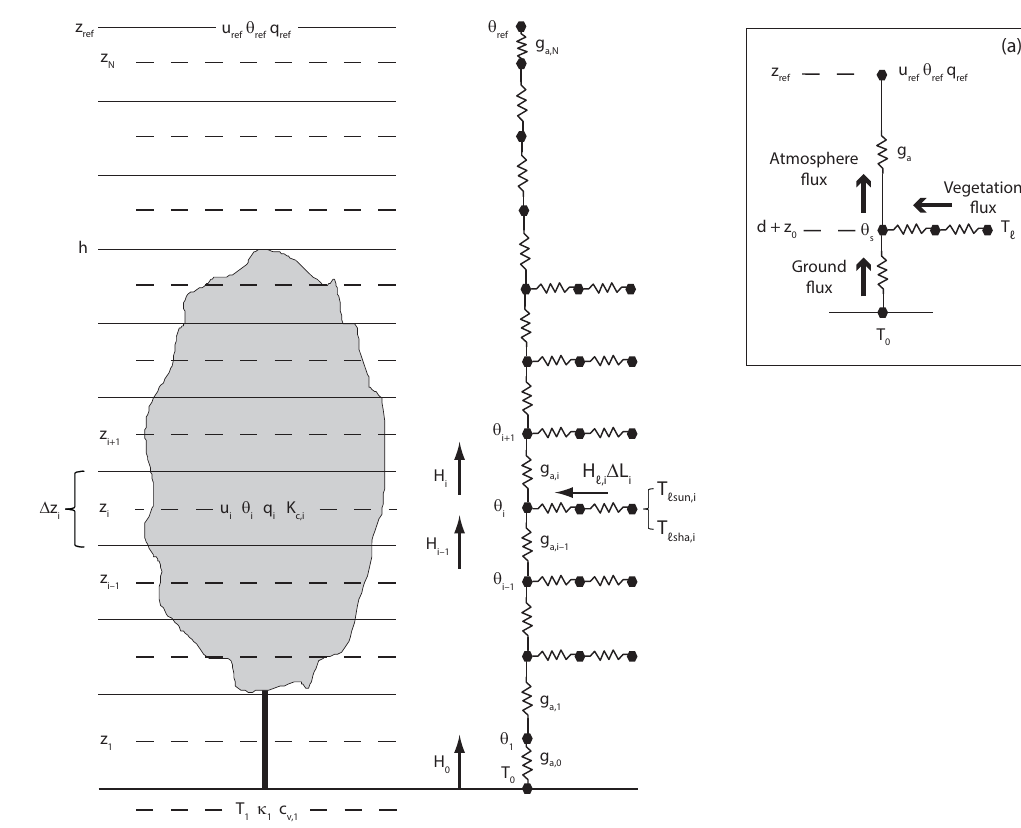
Figure 1. Numerical grid used to represent a multilayer canopy. The volume of air from the reference height ( z ref ) to the ground consists of N layers with a thickness (cid:49)z i , plant area index (cid:49)L i , and plant area density a i = (cid:49)L i /(cid:49)z i . The canopy has a height h . Wind speed ( u i ), temperature ( θ i ), water vapor concentration ( q i ), and scalar diffusivity ( K c ,i ) are physically centered in each layer at height z i . An aerodynamic ( g a ,i ) regulates the turbulent flux between layer i and i + 1. The right-hand side of the figure depicts the sensible heat fluxes below and above layer i ( H i − 1 and H i ) and the total vegetation source–sink flux ( H (cid:96),i (cid:49)L i ) with sunlit and shaded components. Shown is the conductance network, in which nodal points represent scalar values in the air and at the leaf. Canopy source–sink fluxes depend on leaf conductances and leaf temperature, calculated separately for sunlit and shaded leaves using the temperatures T (cid:96) sun ,i and T (cid:96) sha ,i , respectively. The ground is an additional source–sink of heat and water vapor with temperature T 0 . The inset panel (a) shows the dual-source canopy model used in the Community Land Model (CLM4.5). Here, Monin–Obukhov similarity theory provides the flux from the surface with height d + z 0 (displacement height d plus roughness length z 0 ) and temperature θ s to the reference height with the conductance g a . In CLM4.5, d and z 0 are prescribed fractions of canopy